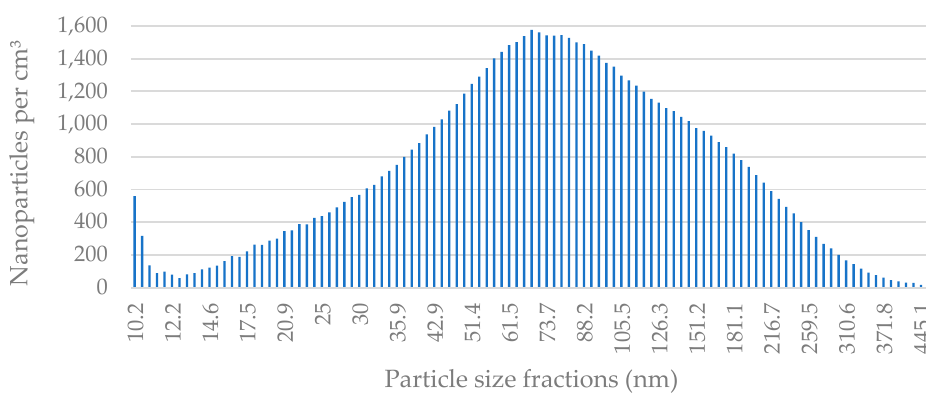
Figure A18. The average nanoparticle concentration in each size fraction in Building 9 during a one-week measurement period during the nonheating season.